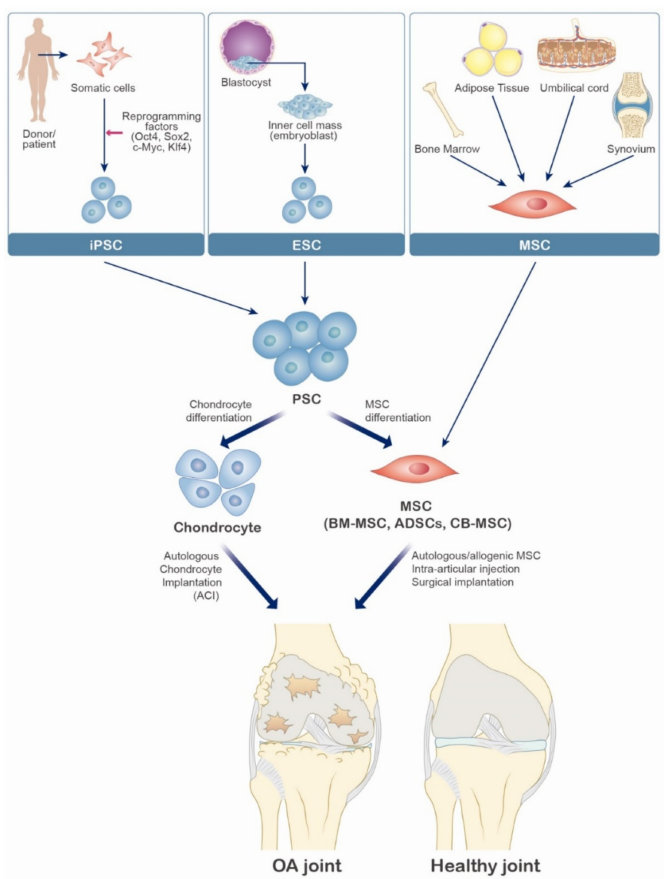
Figure 3. Schematic diagram of various cell-based therapy for osteoarthritis. Embryonic stem cells (ESC), induced pluripotent stem cells (iPSC), and mesenchymal stem cells (MSC) are potential candidates for cartilage regeneration for the OA treatment. MSC can be isolated from bone marrow, adipose tissue, umbilical cord, synovium. Pluripotent stem cells (PSC), including ESC and iPSC, are considered sources for the derivation of chondrocytes and